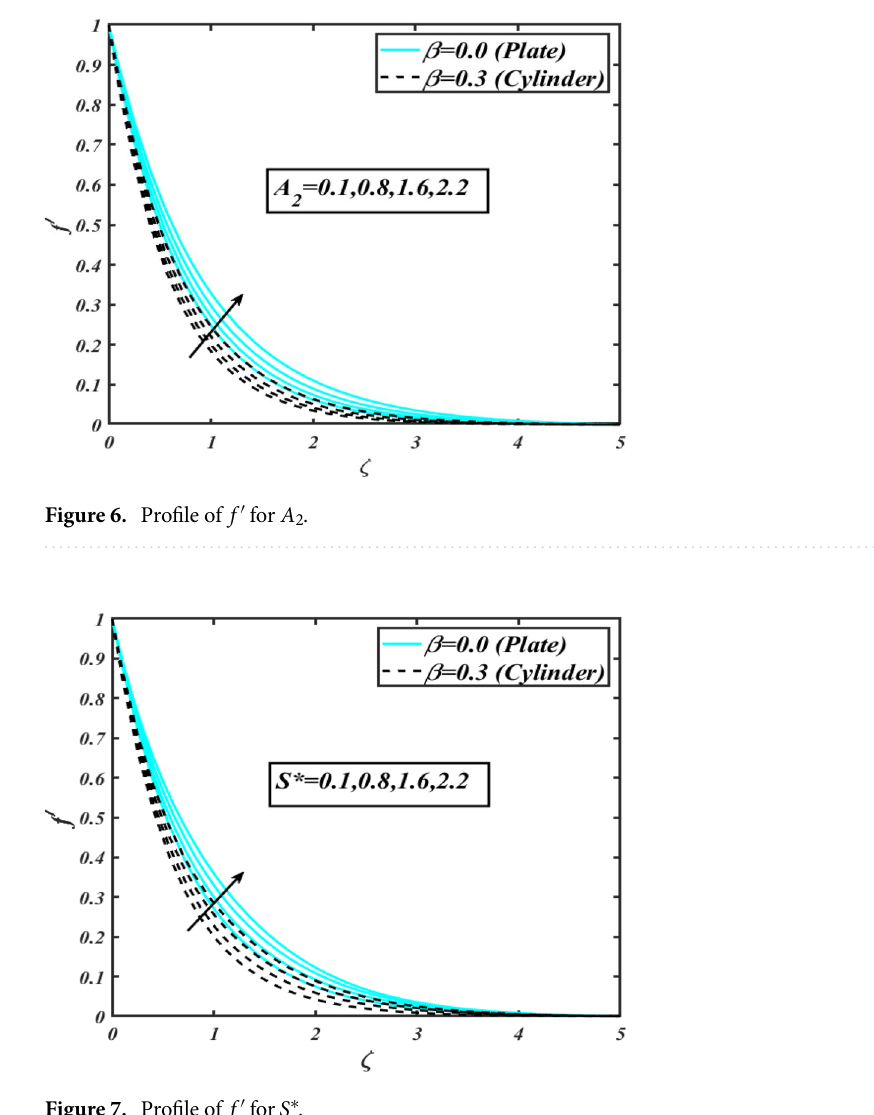
Figure 7. Profile of f ′ for S ∗ .